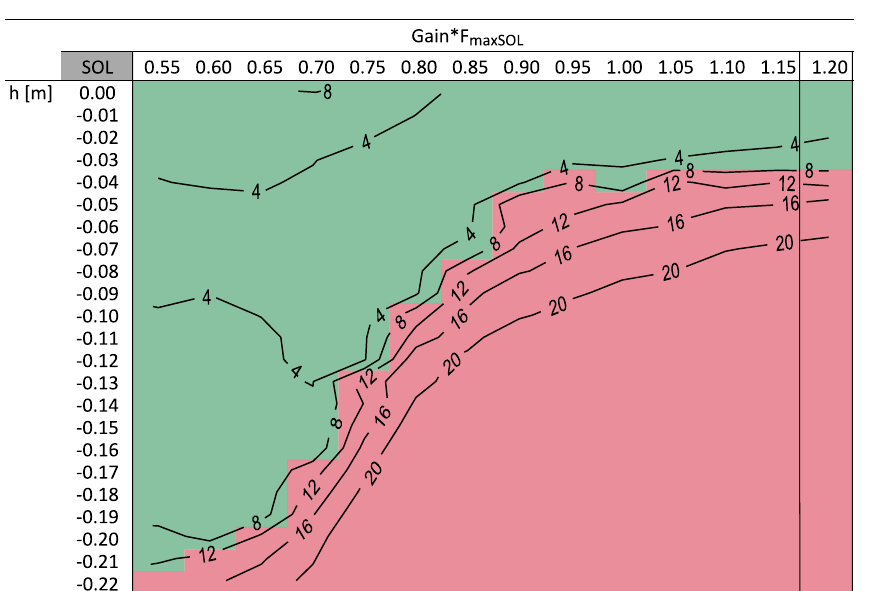
Late anticipation. When the change in feedback gain is delayed by 300 ms after the heel strike of the pre- paratory contact, only the SOL shows noticeable improvements over to the early anticipations. With reduction of the feedback gain 1.2/ F maxSOL to 0.55/ F maxSOL , the model can handle perturbation heights of up to − 0.21 m (Fig. 4). Supplementary Video S2 shows an animation of the trial with late anticipatory SOL adjustment (G with the early anticipatory modification. The model can cope with drops in the ground up to − 0.06 and − 0.16 m, respectively. In both cases, this represents an improvement of − 0.01 m over the early anticipation. For TA and VAS, neither late gain increases nor late gain decreases bring any benefit in robustness, i.e., allow the model to